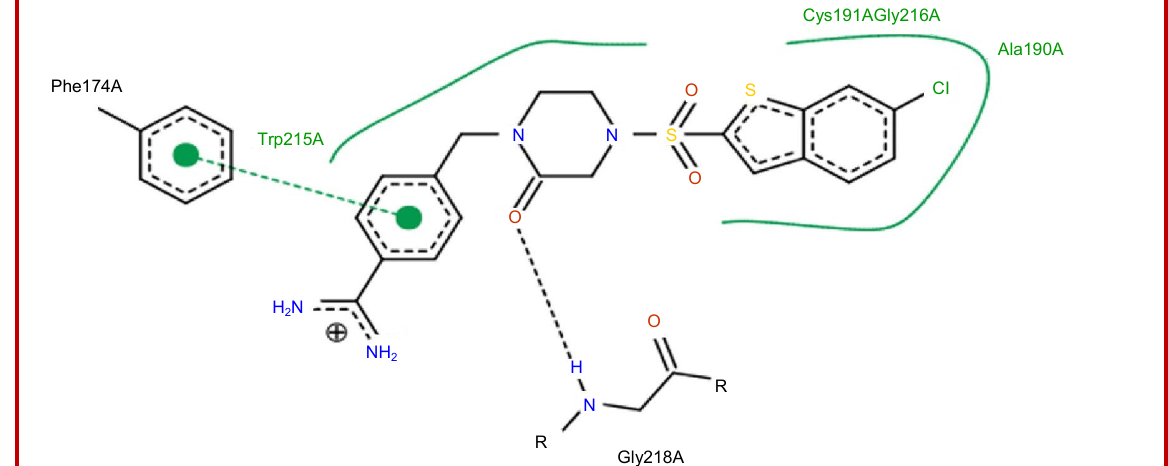
Figure 2: Graphical representation of RPR132747 interaction with protein